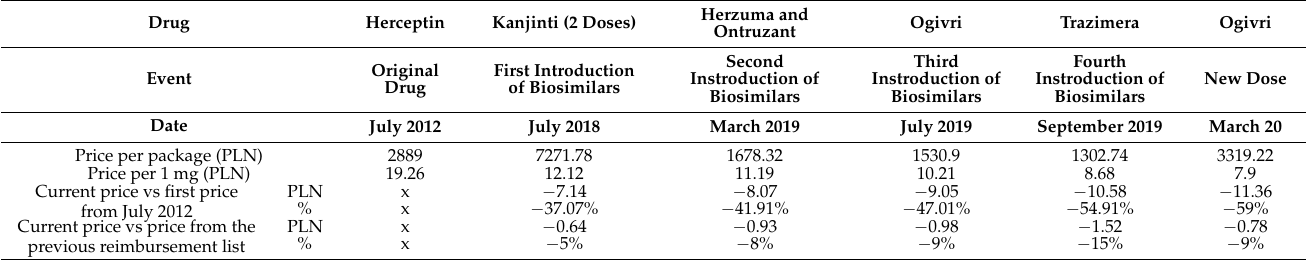
Table 4. Gross wholesale price changes between July 2012 and March 2020 of trastuzumab after biosimilar reimbursement.